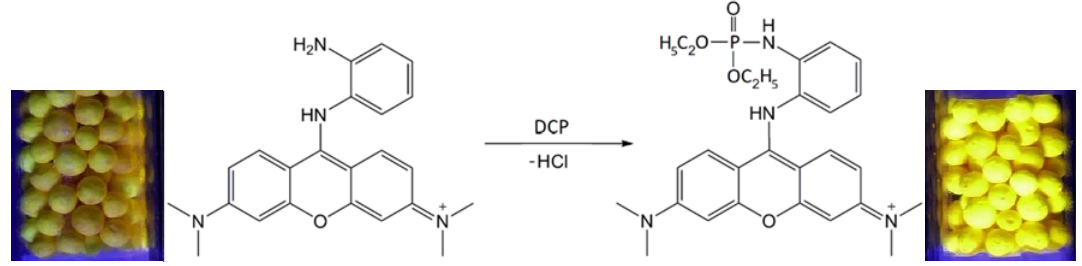
Figure 6. Schematic of the PY ‐ OPD reaction with DPC and the effect of DCP fluorescence on the indication charge.